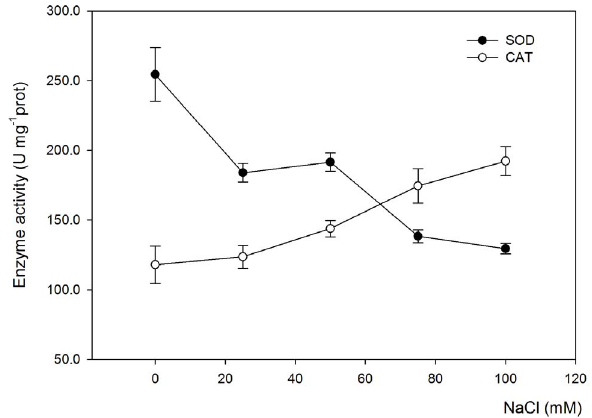
Figure 3. The effects of various NaCl concentrations on the osmolyte contents of Salvia miltiorrhiza leaves. The osmolyte contents measured in the experiment include the soluble protein and soluble sugar contents. Salvia miltiorrhiza seedlings were cultivated in 1/2 Hoagland nutrient solution for 3 weeks and were later exposed to salt stress by adding NaCl up to 25, 50, 75 and 100 mM of the hydroponic solution for 30 days. Non-treated plants were used as controls (0 mM NaCl). Error bars represent the standard errors (SE) of the means.